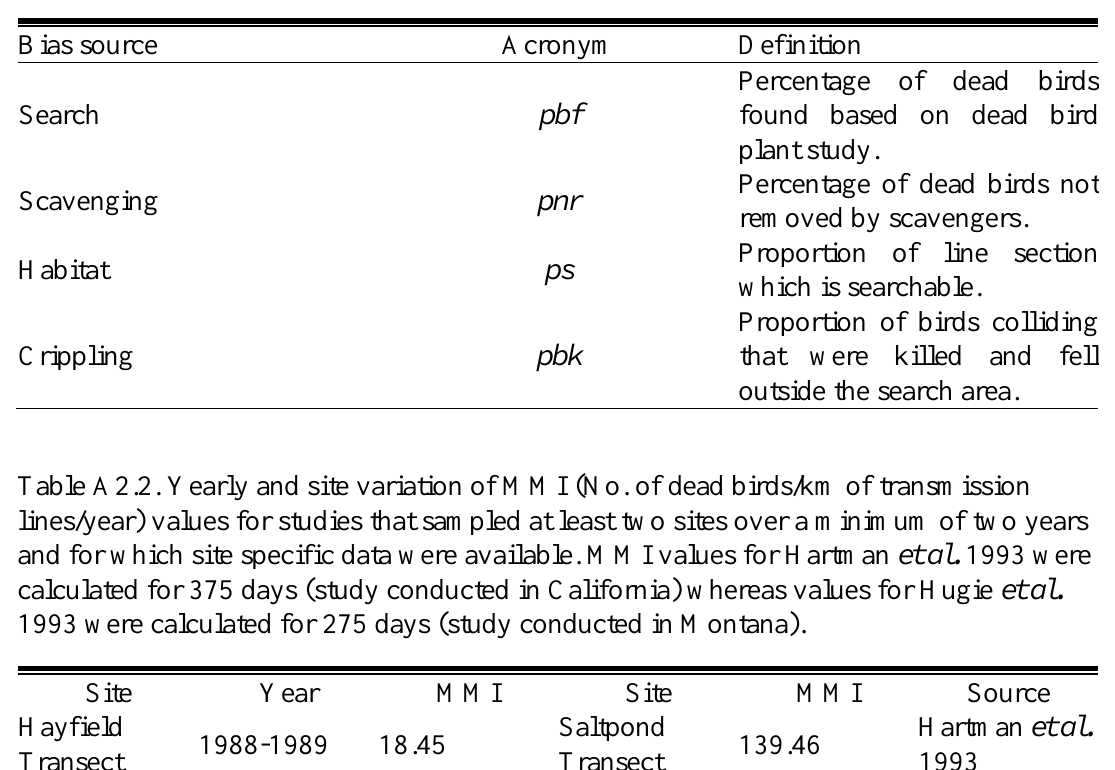
Table A2.1. Definition of bias sources and associated acronyms from Bevanger (1995).